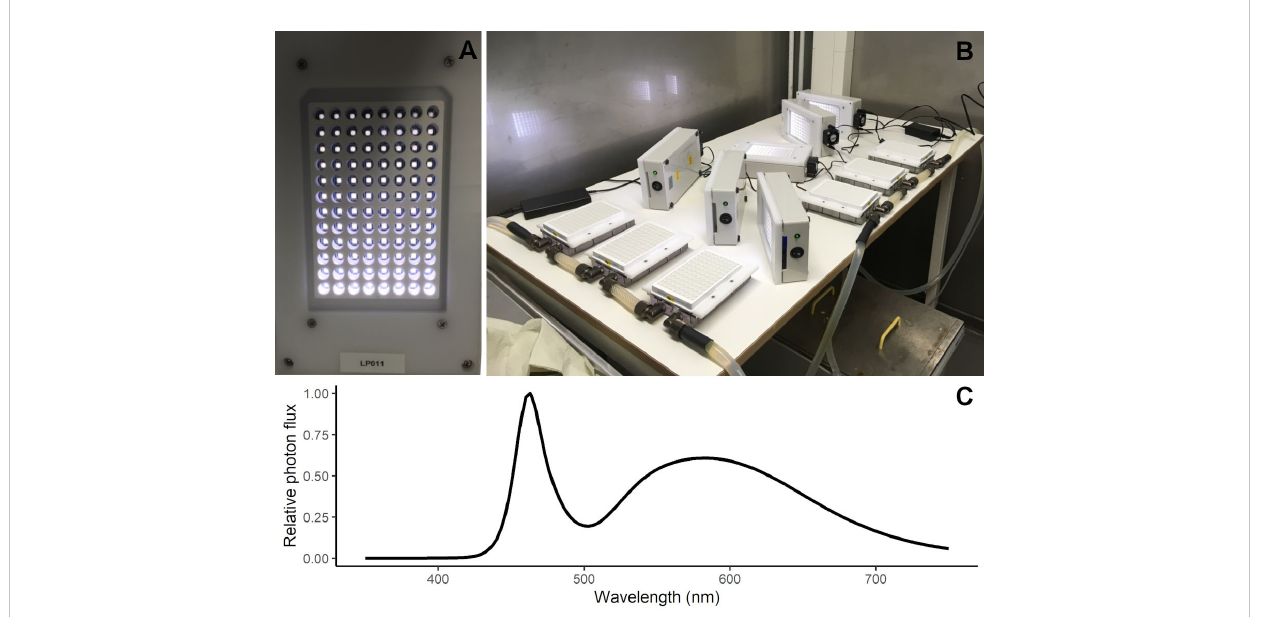
FIGURE 1 High-throughput well-plate setup used in the experiments. Detail on the LED plate for illuminating individual wells (A) and experiment setup showing the 96-well plates positioned on the temperature-controlled cooling plates with LED panels to the side, ready to be mounted over the well-plates (B) . Measured light spectrum (as relative photon fl ux) in the LED panels used in the experiment (C)